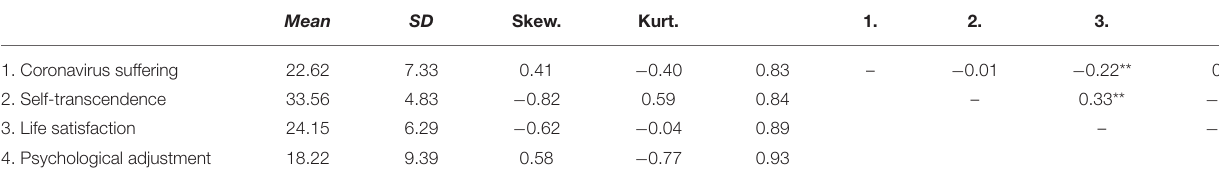
TABLE 3 | Descriptive statistics and correlations for the study variables.